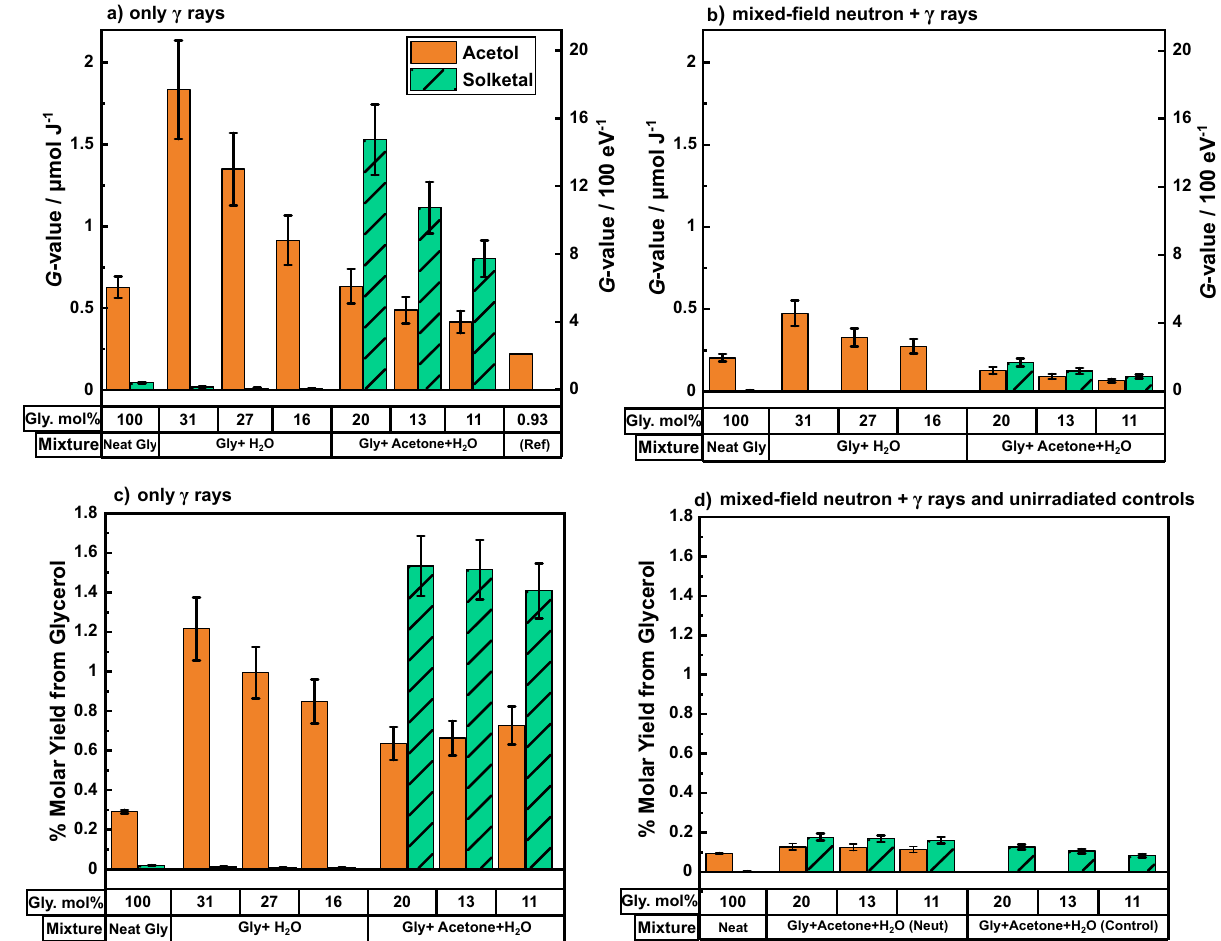
Mixture Fig. 2 G -values and % molar yields for acetol and solketal from glycerol mixtures. After 50 kGy irradiations of binary aqueous and ternary glycerol mixtures. a G -values for only γ -ray irradiations with an average dose rate of 40 Gy min − 1 . b G -values for mixed- fi eld neutron + γ -ray irradiations with a dose rate of 3260 Gy min − 1 . c % molar yields for only γ -ray irradiations. d % molar yields of mixed- fi eld and unirradiated control samples. The indicated ternary mixtures containing glycerol, acetone and water have the following compositions in mol.%: (i) 20, 20, 60; (ii) 13, 21, 65; and (iii) 11, 32, 56, respectively. (See Supplementary Table 5 for data.) G -value error bars represent the combination of errors from the RSD% of analyte concentration curves and absorbed dose uncertainties for each sample. %Molar yield errors derive only from the RSD% of analyte concentration curves for each sample. Reference data from Baugh et al.: (Ref) 29 , for acetol used in ( a ), used N 2 O-saturated aqueous glycerol samples with a γ -ray dose and dose rate of 1.4 kGy and 8 Gy min − 1 ,